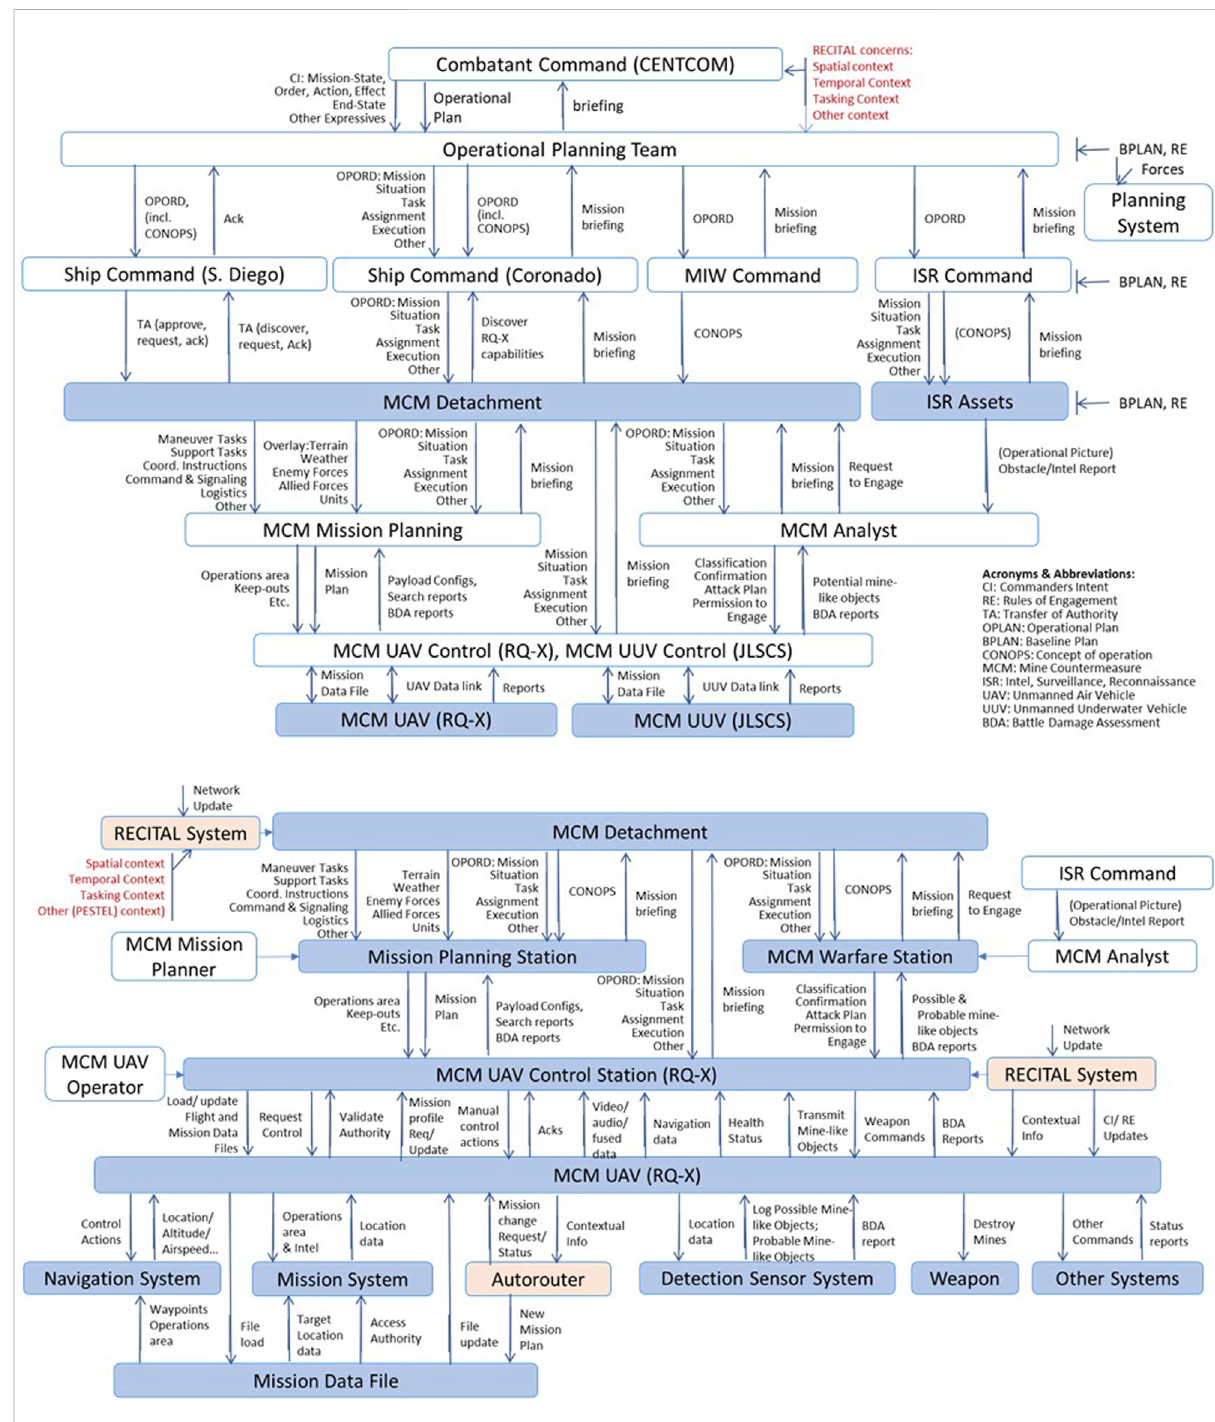
TopandbottomhalvesofthehierarchicalcontrolmodelfocusedonmissionlevelinformationtransfersintheMCMmissioninvolvingtheRQ-X UAV and JLSCS UUV. The bottom half of the hierarchical control model is just for the RQ-X